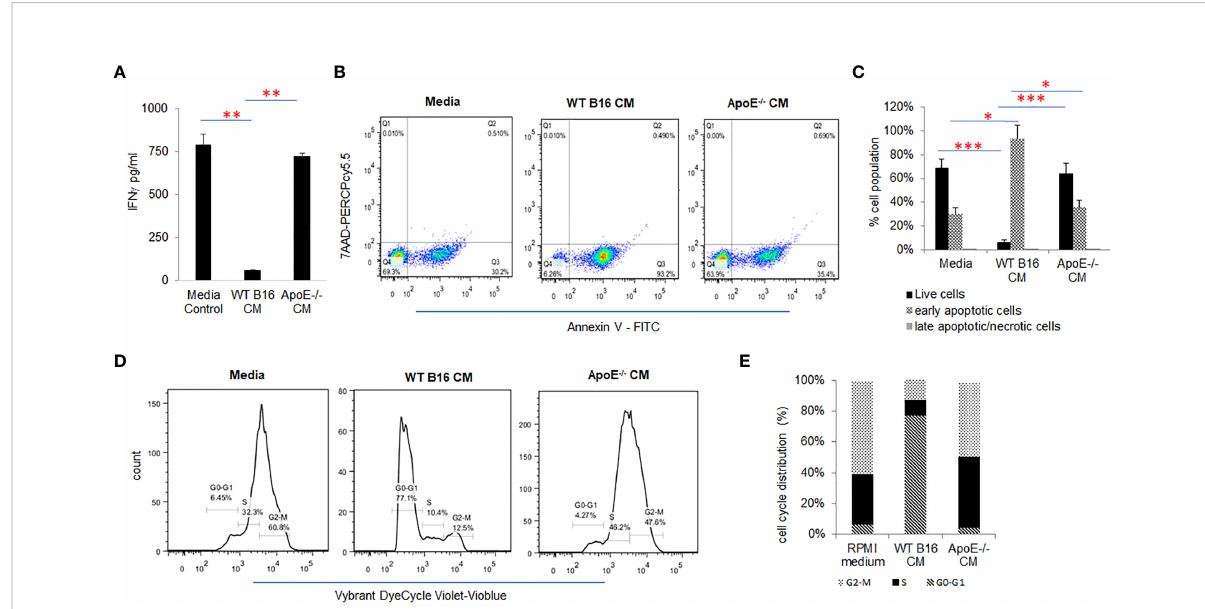
FIGURE 2 ApoE secreted into media from B16 melanoma tumor cells inhibits T-cell proliferation and function. (A) Conditioned media (CM) from WT or apoE -/- cells was cultured with T-cells activated by CD3/CD28 beads. Bar graphs depict IFN g released under these conditions. The production of IFN g was signi fi cantly suppressed when T cells were cultured in WT B16 CM, but this suppression was reversed in apoE free CM from apoE -/- cells. (B) Representative fl ow cytometry plots and (C) quanti fi cation of T cell apoptosis in CM. Results show that T cell viability is markedly reduced in the WT CM, whereas induction of apoptosis was reversed when cells were cultured in the apoE -/- medium, similar to RPMI control medium alone. (D) Representative fl ow cytometry plots and (E) quanti fi cation of cell cycle analysis of T cells in different media. Cell cycle distribution showed an arrest of activated T cells in the G0-G1 phase in the WT B16 medium, while in the apoE -/- medium most T cells were distributed in the S and G2-M phases, similar to the RPMI media control. Results are expressed as mean score ± SD. *p<0.05; **p<0.005; ***p<0.001, determined by unpaired two-tailed Student ’ s